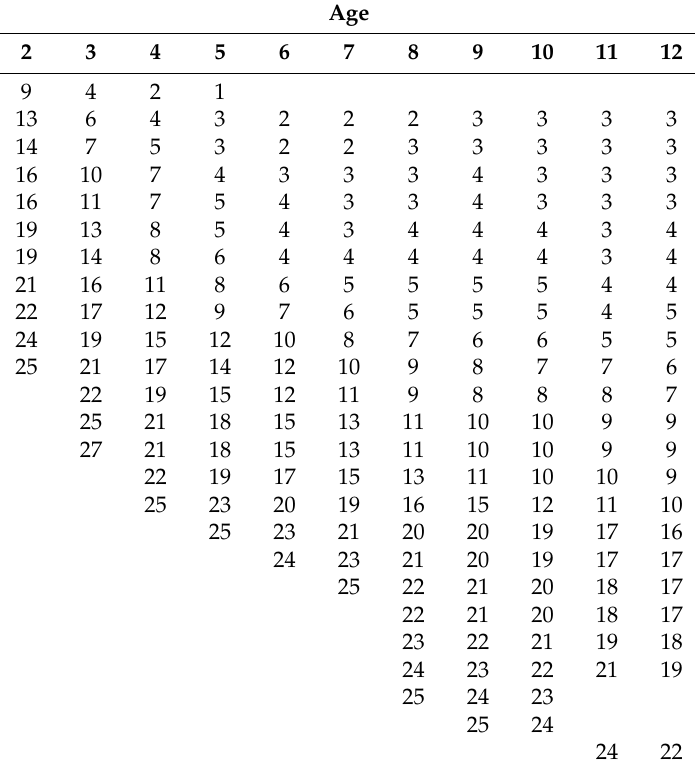
Figure 6. Continuous changes of the Health/Physical/Behavior subscale score over age calculated from pair-wise observations using the “relay” procedure. Table 2. Speech/Language/Communication subscale score norms as a function of the initial score and age from Figure